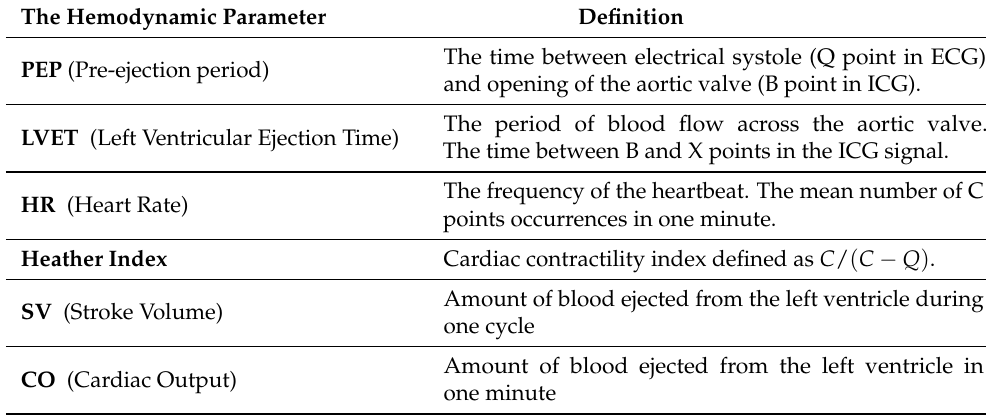
Table 2. A brief description of the most popular hemodynamic parameters inferred from the positions of the characteristic points in the ECG and ICG